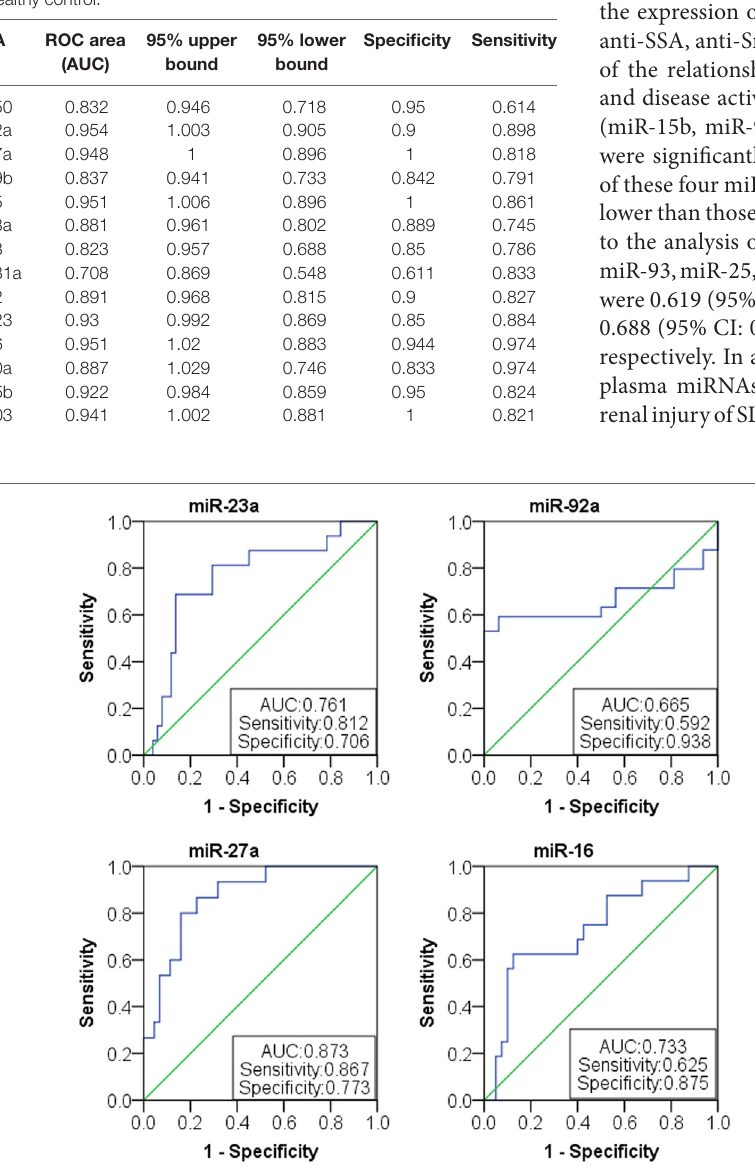
TaBle 4 | Receiver operating characteristic (ROC) curve (AUC) for 14 microRNAs (miRNAs) in discriminating systemic lupus erythematosus patients from healthy control.